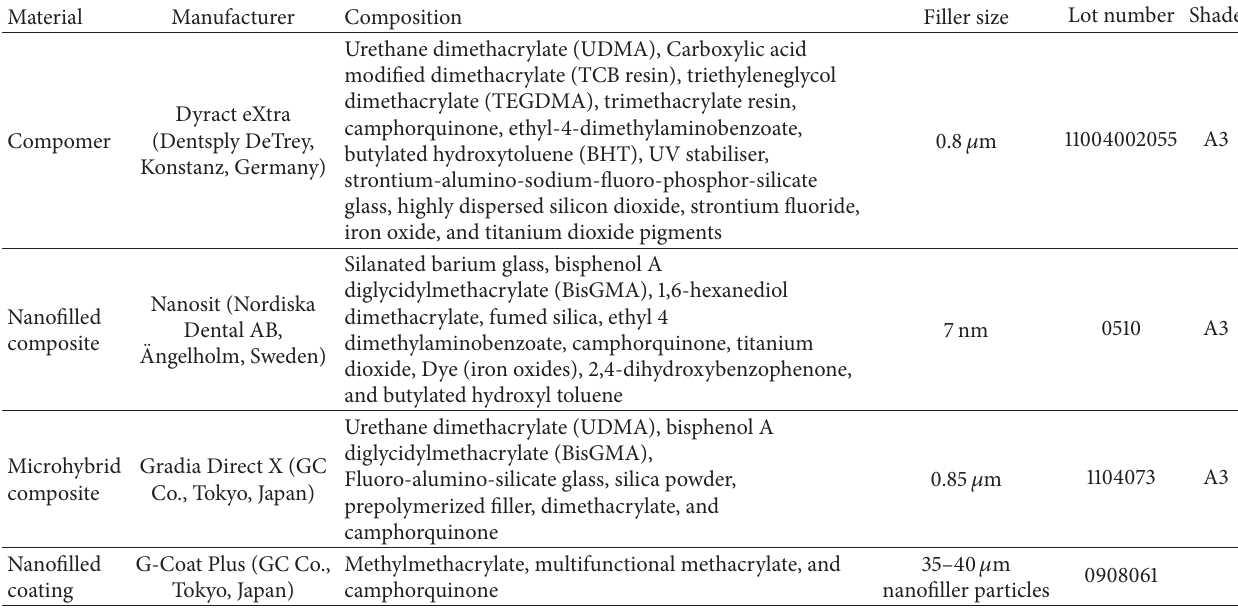
Table 1: Composition of the